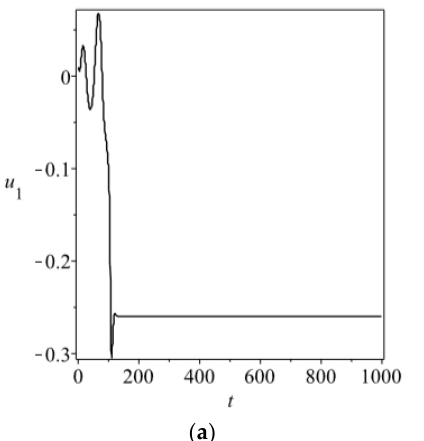
Figure 1. Dynamics of Equation (2) with a = 0.1, b = 0.08, γ = 3, c = 0.16. The initial conditions are taken as u 1 ( 0 ) = 0.01, u 2 ( 0 ) = 0, u 3 ( 0 ) = 0.02, u 4 ( 0 ) = 0.01; ( a ) u 1 ( t ) vs. t ; ( b ) u 2 ( t ) vs. t ; ( c ) u 3 ( t ) vs. t ; ( d ) u 4 ( t ) vs. t .